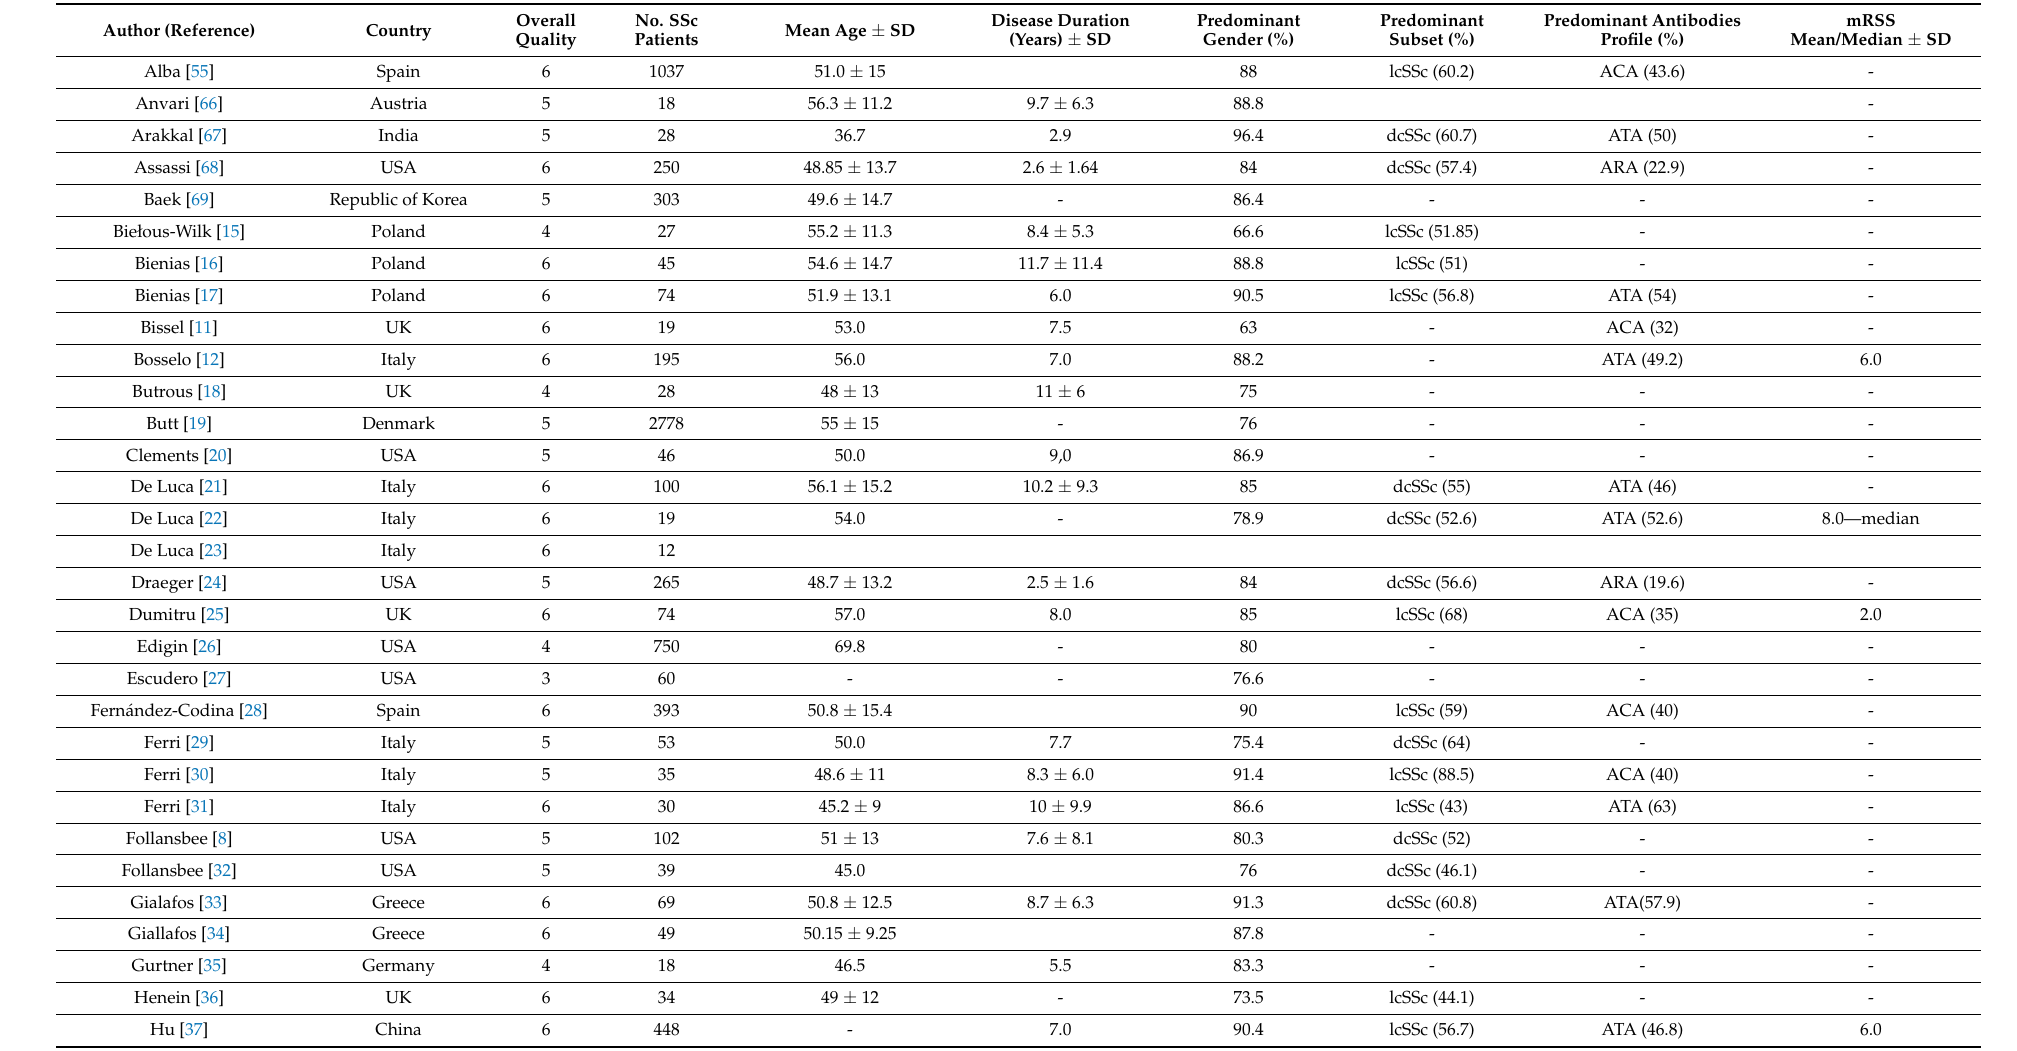
Table 1. Characteristic of